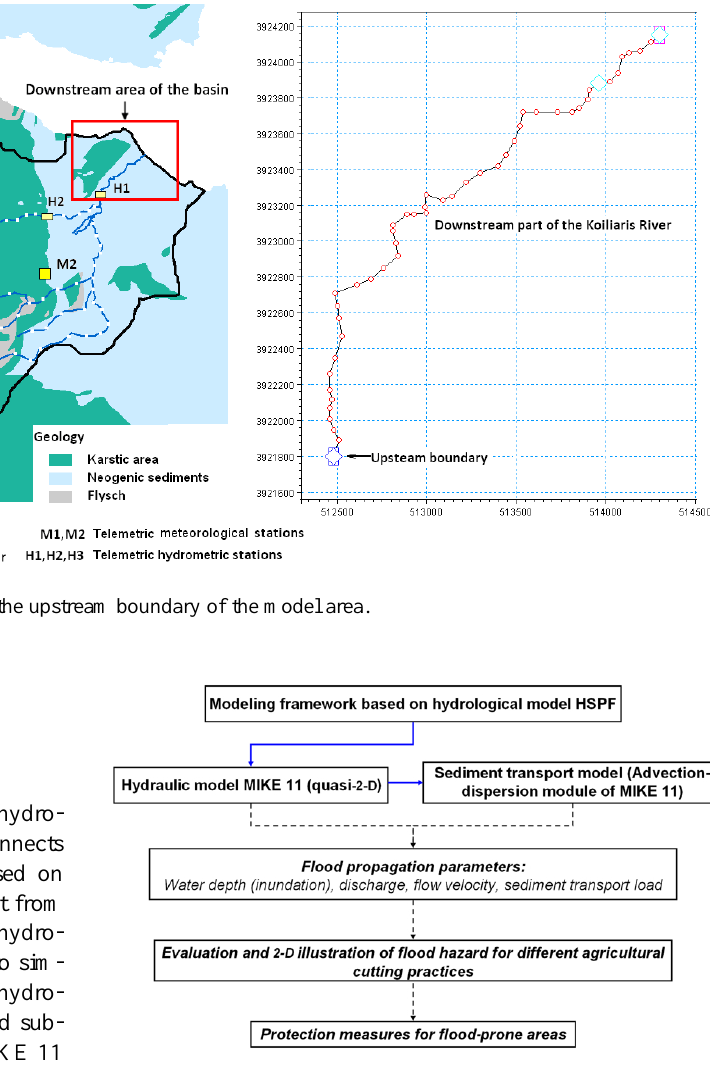
Fig. 2. Flow chart of the proposed hydro-sedimentary modeling sys-